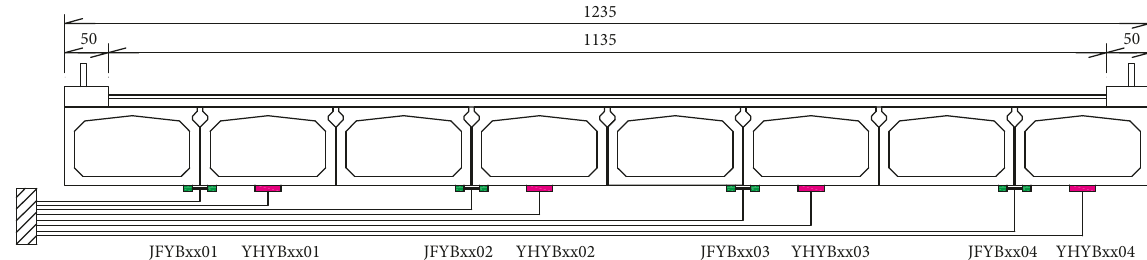
Figure 17: Layout of strain measurement points.